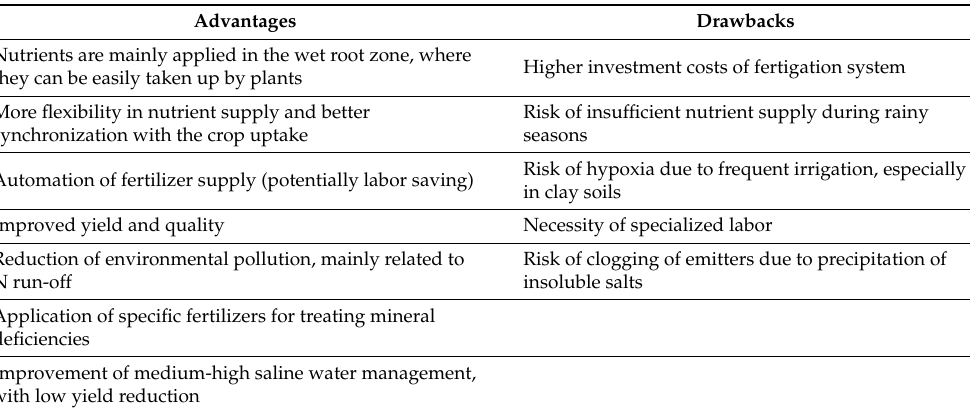
Table 1. The main advantages and drawbacks of